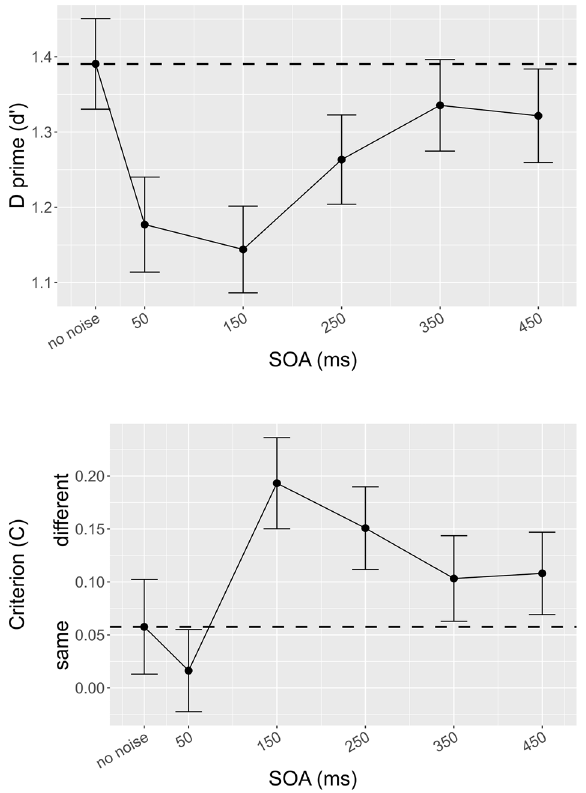
Figure 2. The upper panel shows d’ as a function of SOA (no-noise, 50, 150, 250, 350, 450 ms). The lower panel shows the response criterion as a function of SOA (no-noise, 50, 150, 250, 350, 450 ms). Black dots represent mean values with standard errors. The black dashed line represents the baseline no-noise